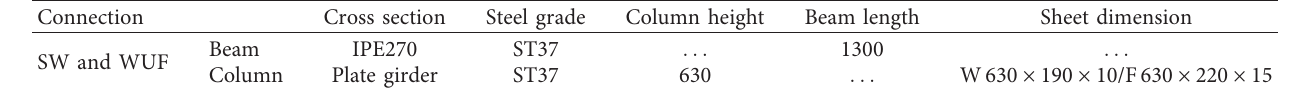
Figure 8: Stress-strain diagram of the experimental specimen [3]. Table 1: Modelled subassembly (units in